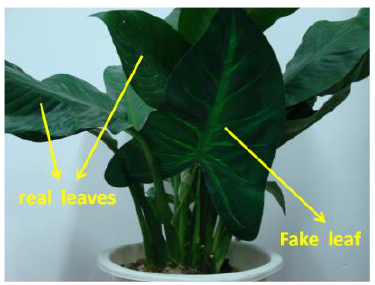
Table 1 key parameters of the multi-spectral canopy